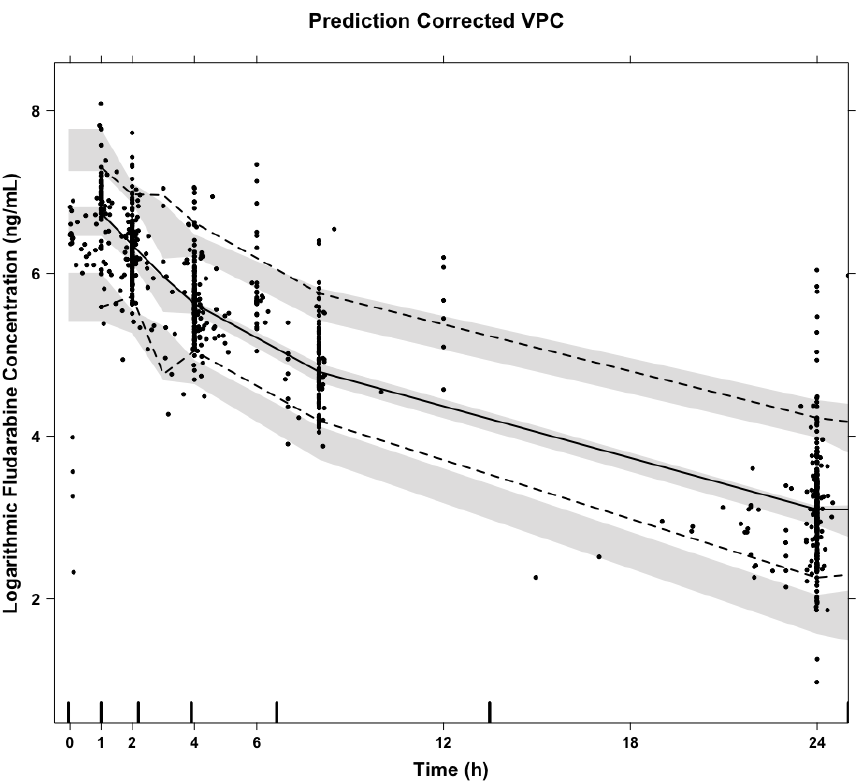
Scheme A1. Prediction corrected visual predictive check of the refined f-ara-a model. F-ara-a concentrations (ng/mL) over time after dose (h) of the combined data set. The solid and dashed lines represent the median, 5th, and 95th percentile of observed f-ara-a concentrations, respectively. The shaded areas represent the prediction intervals generated by the popPK model for the median, 5th, and 95th percentiles, respectively.